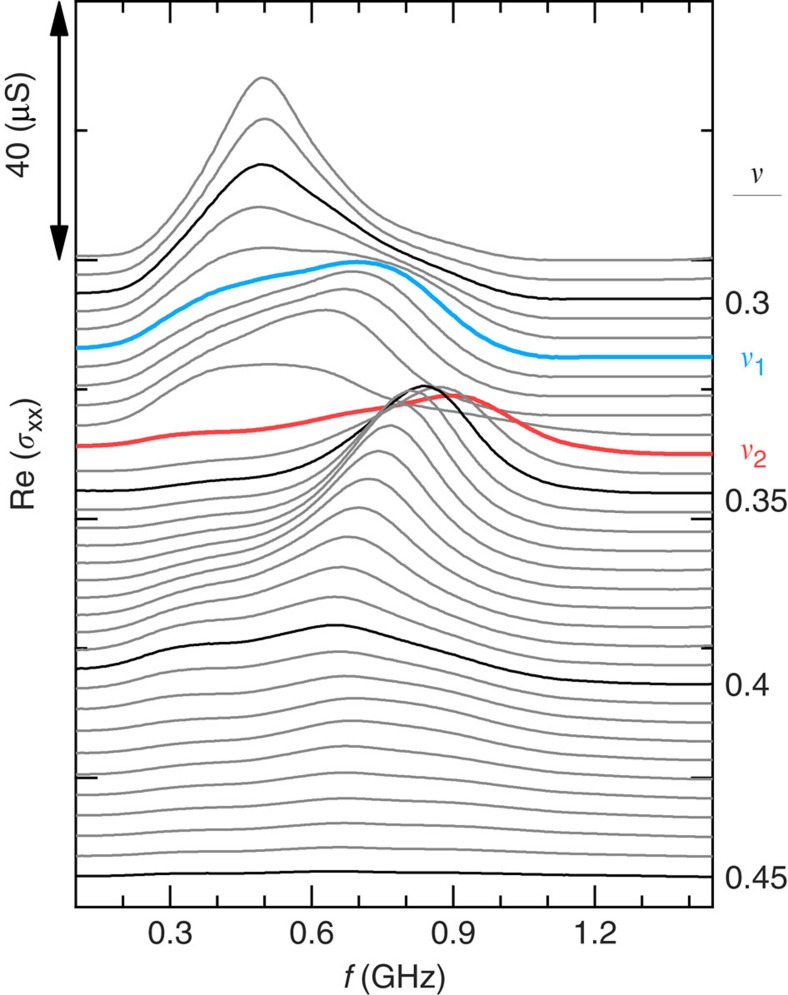
Two transitions in microwave spectra.Microwave spectra, Re (σxx), versus frequency, f, at fixed ν from 0.29 to 0.45 vertically offset for clarity as marked on the right axis with step of 0.005, at n=1.26. Vertical scale is marked on the left axis. The spectra at low ν are dominated by a pinning mode resonance attributed to an electron solid. The spectra suggest the occurrence of two transitions within the solid, one at ν=0.315 and the other at ν=0.34, marked as ν1 and ν2, respectively. At each transition the peak frequency, fpk, exhibits an abrupt upward jump, and the amplitude of the resonance exhibits a minimum. The broad, weak peak at ∼0.3 GHz is an artefact because of a reflection near the sample mounting.